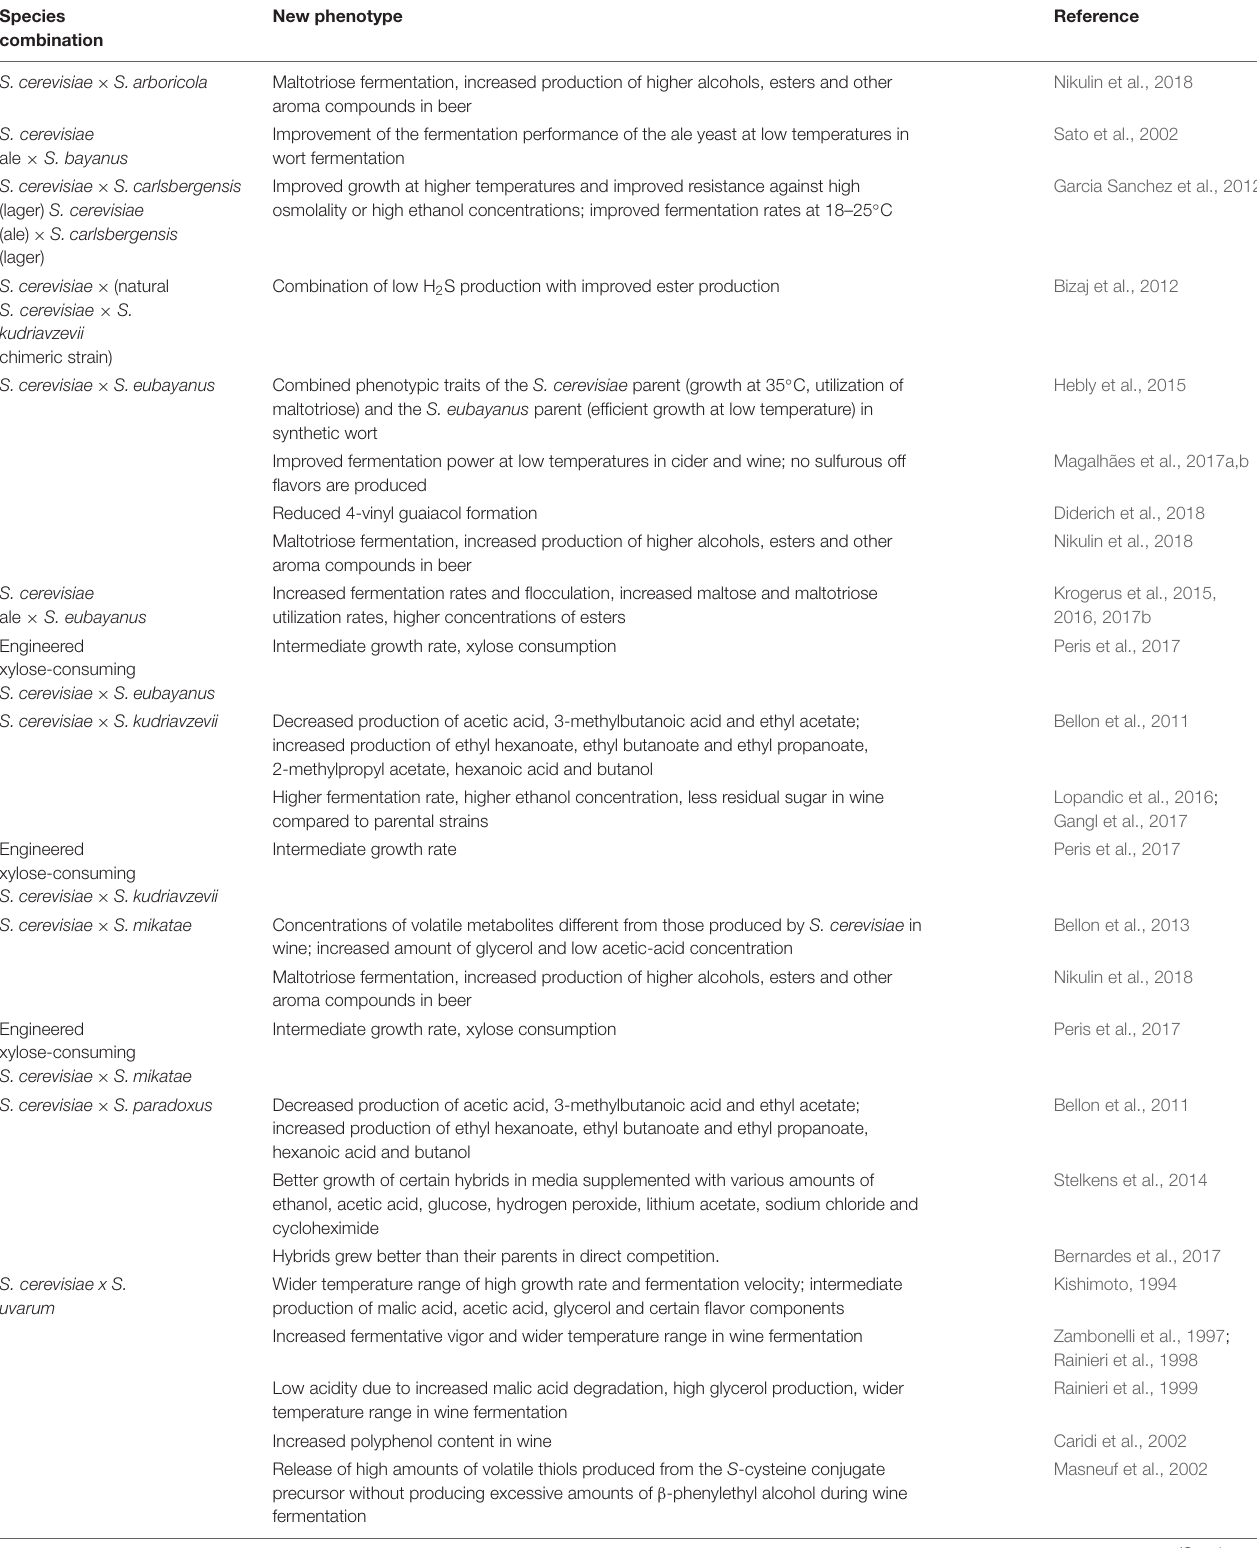
TABLE 1 | Examples of interspecies hybridisation: phenotypes of the hybrid